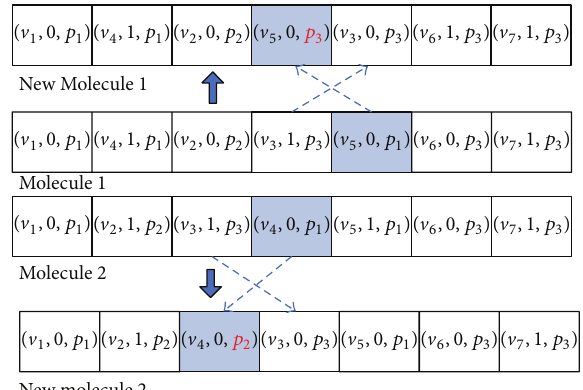
Figure 8: Illustration of molecular structure change for intermolec- ular ineffective collision.